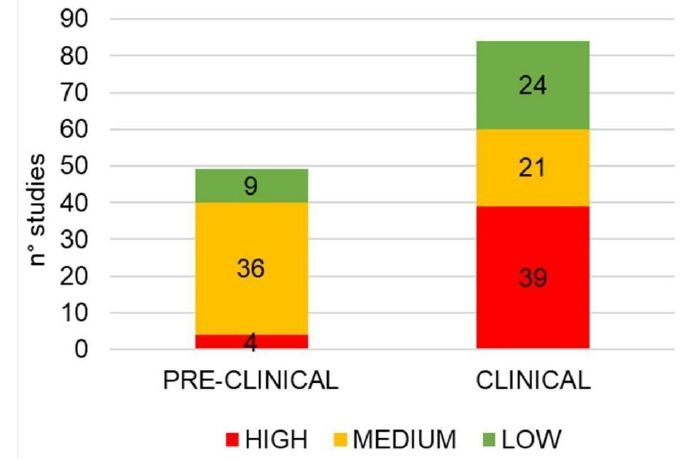
Figure 4. The quality assessment is based on a checklist adapted from the Cochrane Handbook for Systematic Reviews of Interventions. The preclinical and clinical studies have been classified as being of high (red section), medium (yellow section), and low risk (green section) of bias; n° = number.